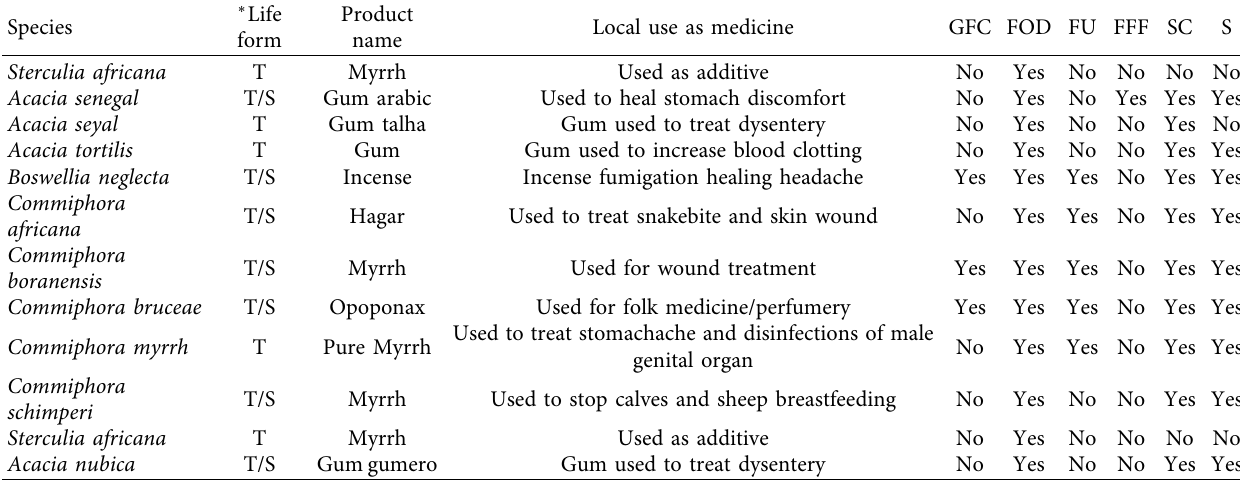
Table 3: Summary of gum and resin bearing tree species and their local use for both districts in South Omo Zone. Species